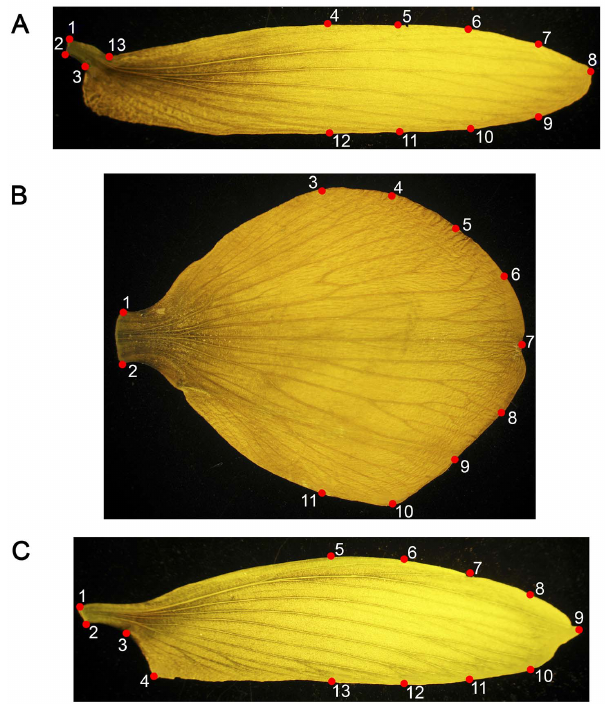
Fig. 1. Homologous landmark map of the floral elements. a) wing 13 landmarks, b) standard 11 landmarks c) keel 13 landmarks.